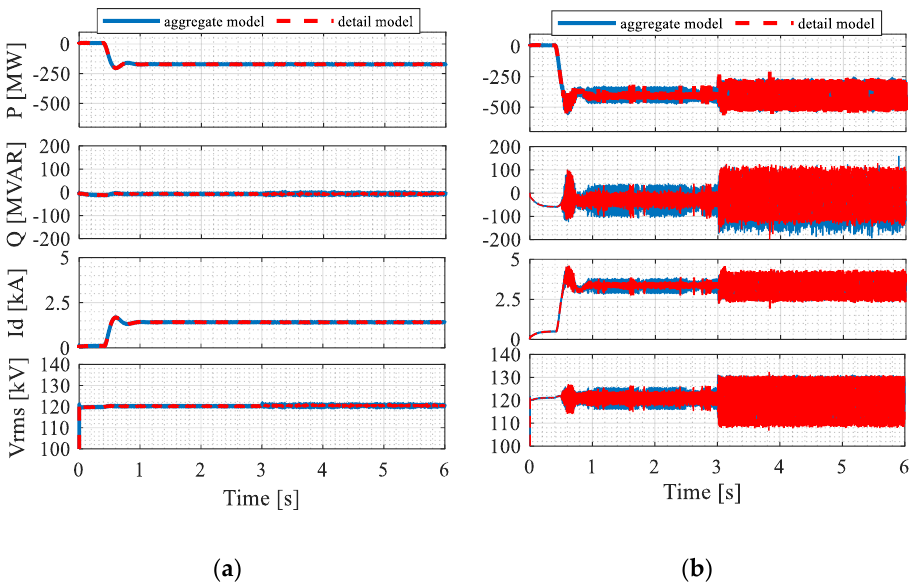
Figure 15. IBR plant response in case of three phase to ground fault in transmission line ( a ) strong grid scenario, ( b ) weak grid scenario.